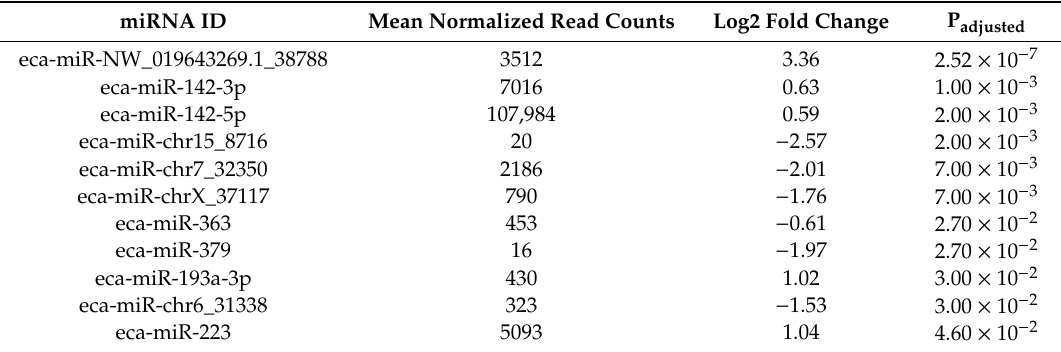
Table 4. Di ff erentially expressed miRNAs comparing asthmatic horses in remission and control horses. The mean DESeq2 normalized read counts, the log2 fold change, and the adjusted p -values are indicated. miRNA ID Mean Normalized Read Counts Log2 Fold Change